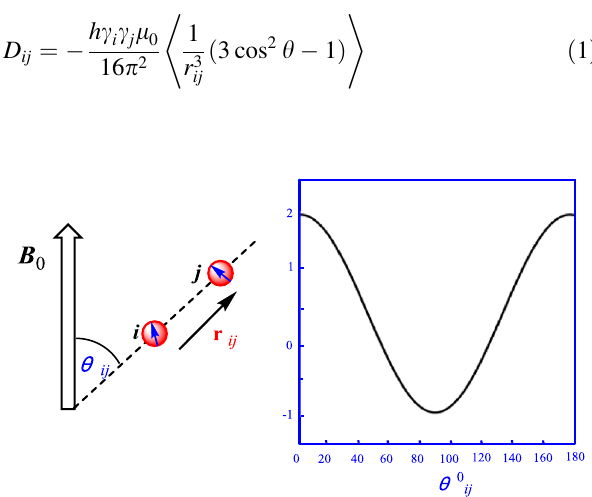
Fig. 1 Schematic representation of two nuclear spins connected by the internuclear vector r ij that encloses an angle h ij with respect to the external magnetic field B 0 ; The exact formula for the dipolar coupling D ij is Eq.